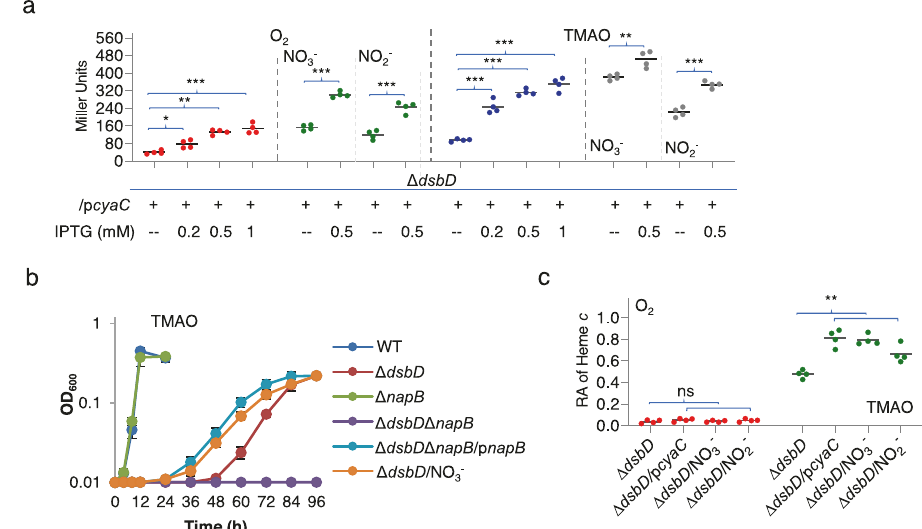
Fig. 5 NapB underlies the effect of cAMP on cyt c biosynthesis of the dsbD mutant. a Expression of napB . Samples were prepared with cells of indicated strains grown to the exponential phase. The promoter activity of nap was assayed by an integrative lacZ reporter. b Growth of indicated strains on EAs speci fi ed. The expression of cyaC (p cyaC ) was driven by IPTG-inducible promoter P tac . Shown was the data in the presence of 0.2 mM IPTG for all panels. The experiments were performed four times, and the data were presented as the average ± SD (error bar). c Heme c levels in strains grown to the early stationary phase. The relative abundance (RA) of heme c was obtained as described in Fig. 2b. In a and c, asterisks indicate statistically signi fi cant difference of the values compared ( n = 4; ns not signi fi cant, p > 0.05; * P < 0.05; ** P < 0.01; *** P < 0.001).